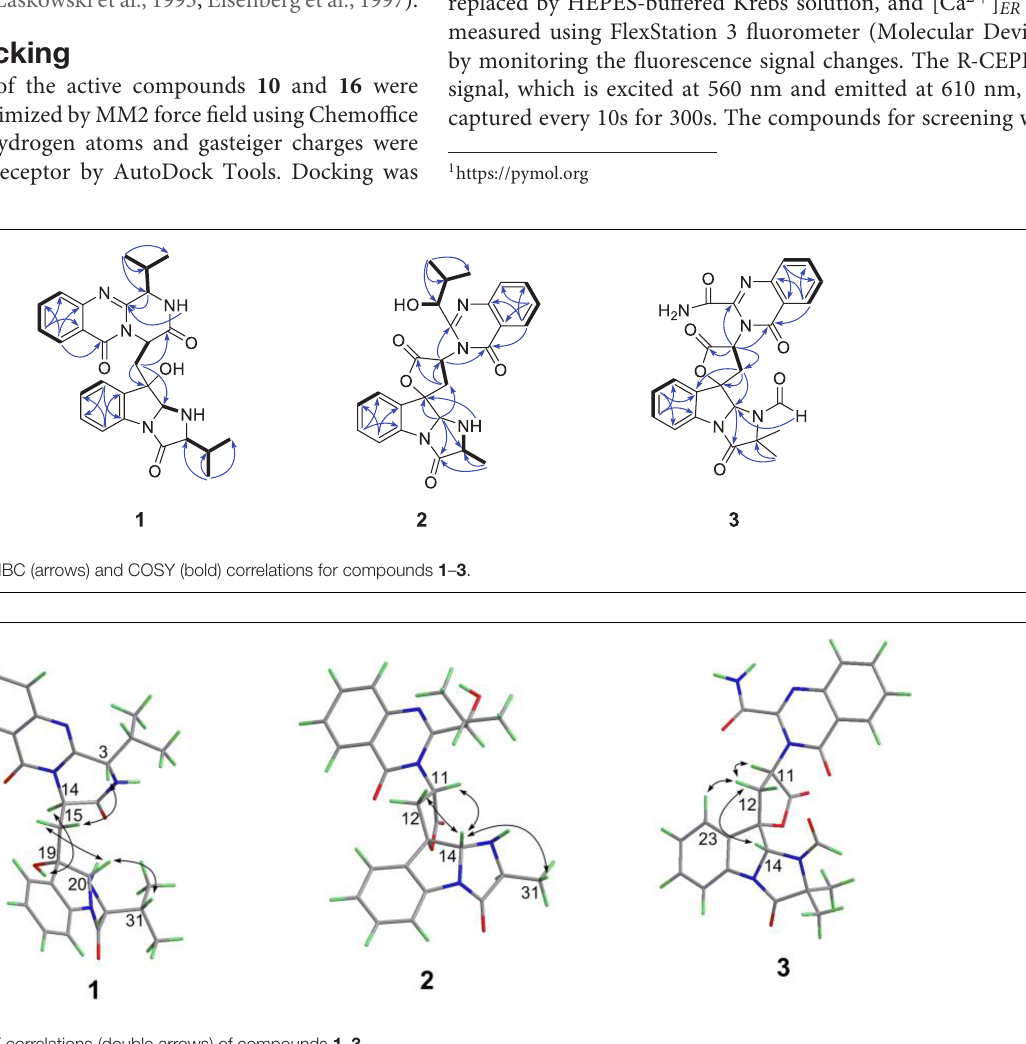
FIGURE 3 | Key ROESY correlations (double arrows) of compounds 1 – 3